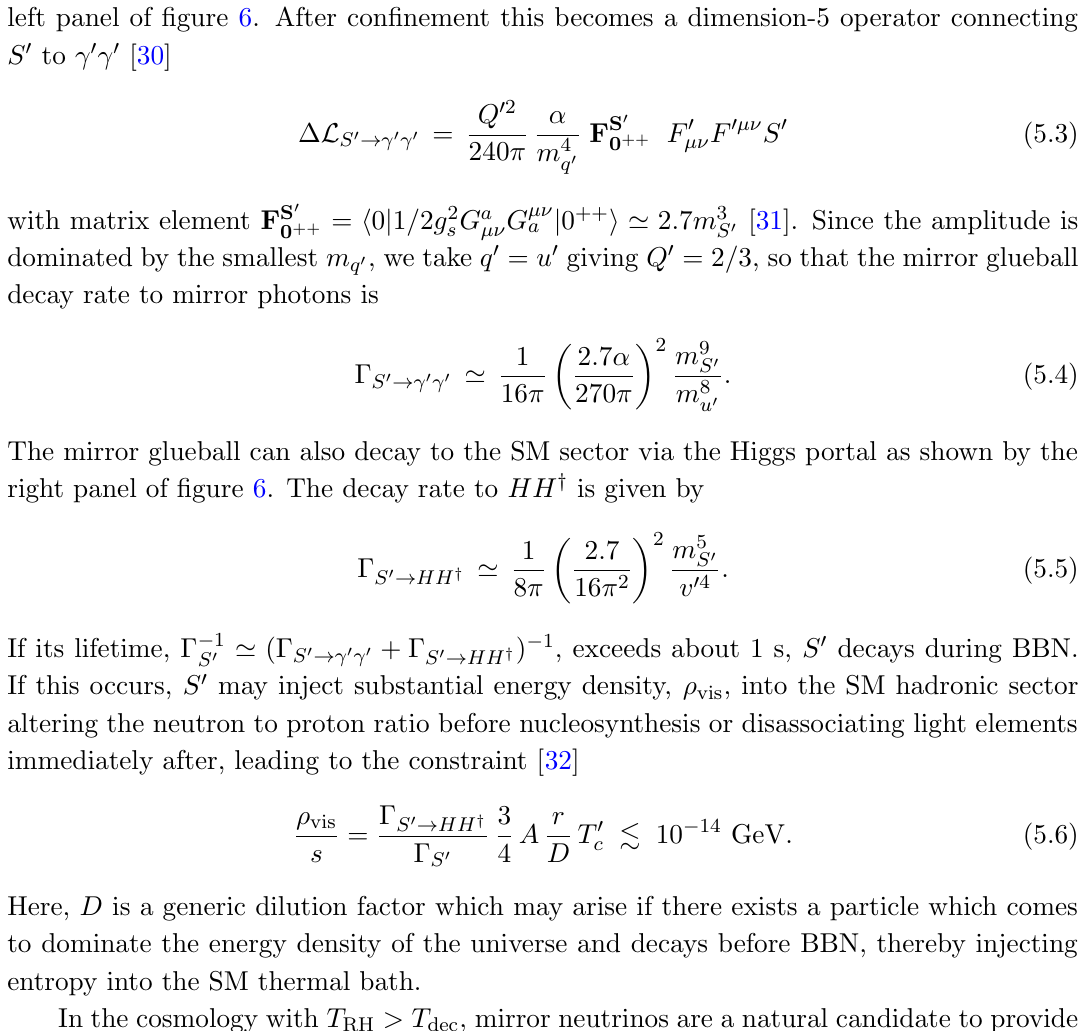
0 (cid:13) 0 (left) and H; H y